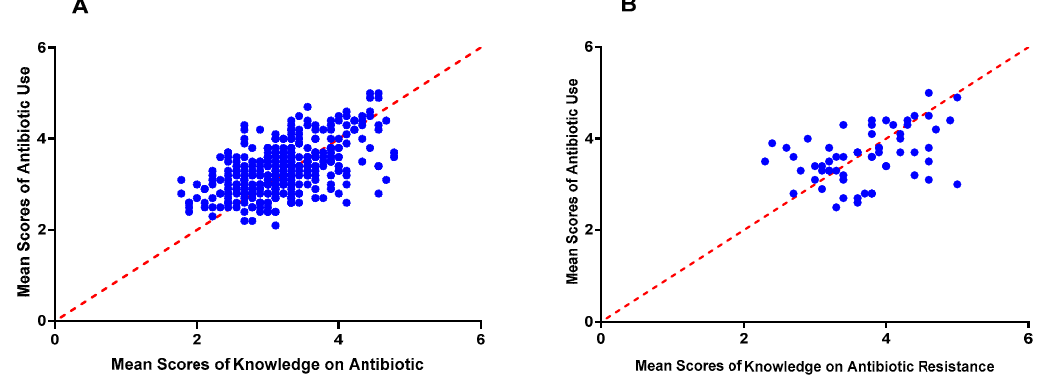
Figure 5. Findings obtained from the participant on antibiotic resistance.